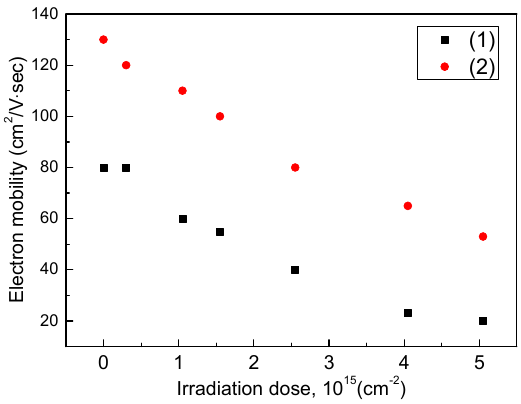
Figure 3. Electron mobility in 3 C -SiC layers vs. proton irradiation dose: (1) 77 K and (2) 300 K.